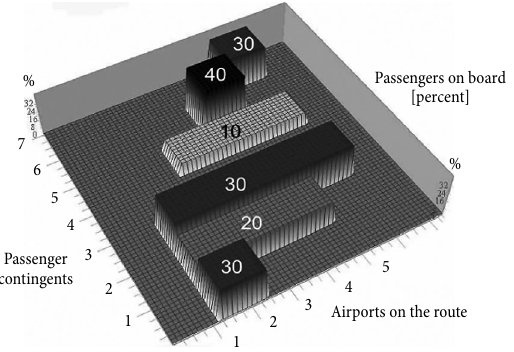
Fig. 7. Airplane’s occupancy on the route for each passenger contingent